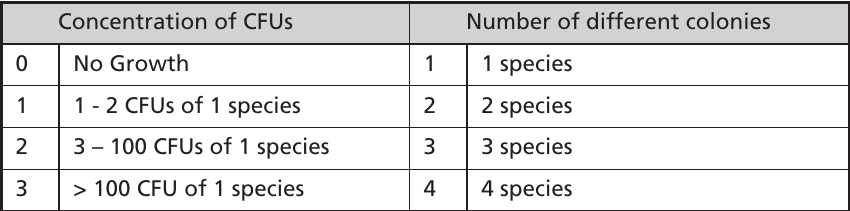
Table 1: Categorisation of Colony Forming Units